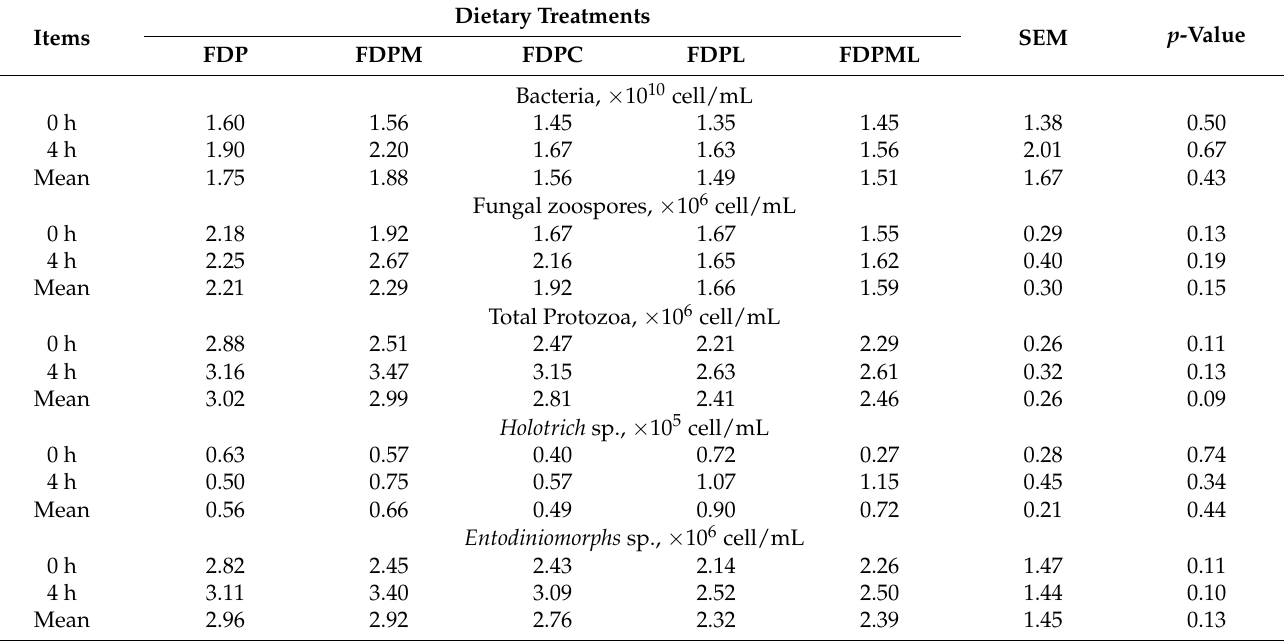
Table 5. Effect of untreated and treated discarded durian peel in TMR on ruminal microbe population in growing goats.